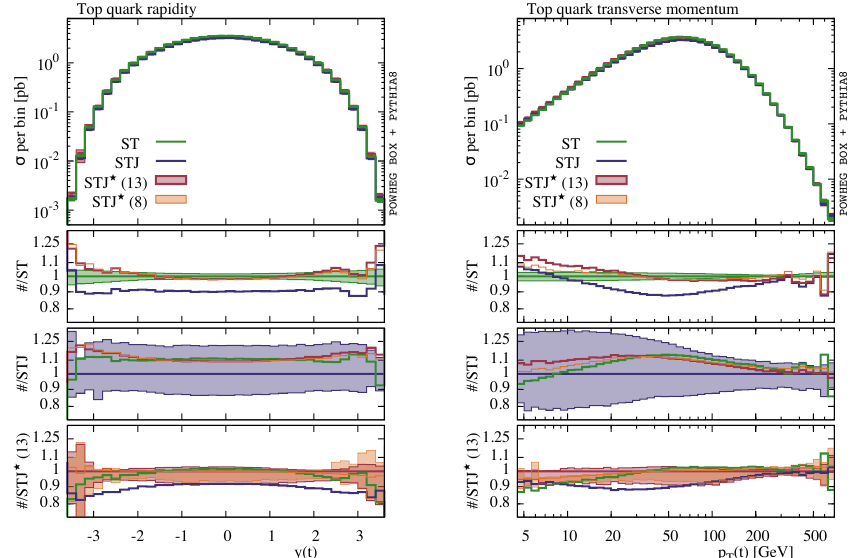
Figure 7 . Here we show the same predictions as in (cid:12)gure 2, but for an 8 TeV rather than a 13 TeV LHC. The left-hand plot shows the rapidity of the top quark in t -channel single-top production, while the right-hand plot shows its transverse momentum. As with the STJ ? predictions in the main text, the STJ ? (13) predictions (red) are obtained by tuning the Minlo Sudakov form factor using 13 TeV LHC ST and STJ event samples. The STJ ? (8) predictions (orange) are obtained by tuning the Minlo Sudakov form factor using 8 TeV LHC ST and STJ event samples. The very good level of agreement between STJ ? (13) and STJ ? (8) predictions points to a high degree of universality in the Sudakov form factor corrections output by the tuning procedure.